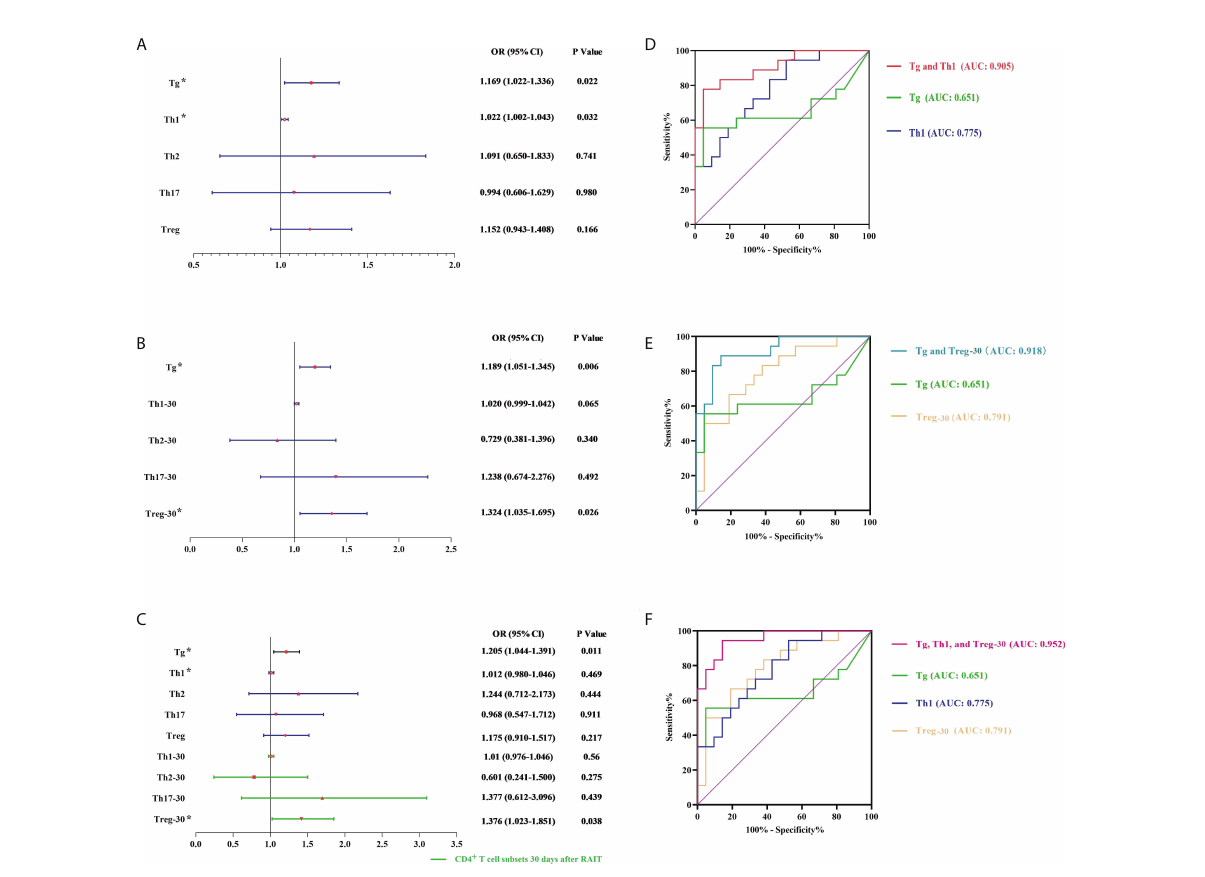
FIGURE 4 Multivariate logistic analysis and receiver operating characteristic (ROC) analysis. (A, D) Model 1 is based on pre-RAIT Tg and absolute counts of pre-RAIT CD4 + T cell subsets. (B, E) Model 2 is based on pre-RAIT Tg and absolute counts of CD4 + T cell subsets 30 d after RAIT. (C, F) Model 3 is based on pre-RAIT Tg and absolute counts of CD4 + T cell subsets before and 30 d after RAIT. RAIT, radioactive iodine treatment; Tg, serum thyroglobulin. * represents the parameters of the model